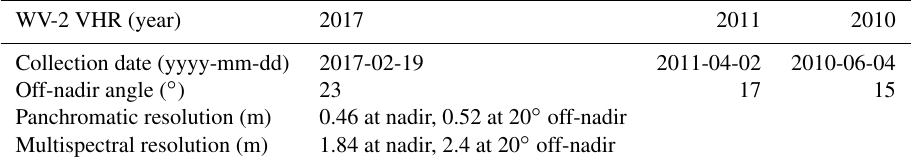
Table 2. VHR optical image